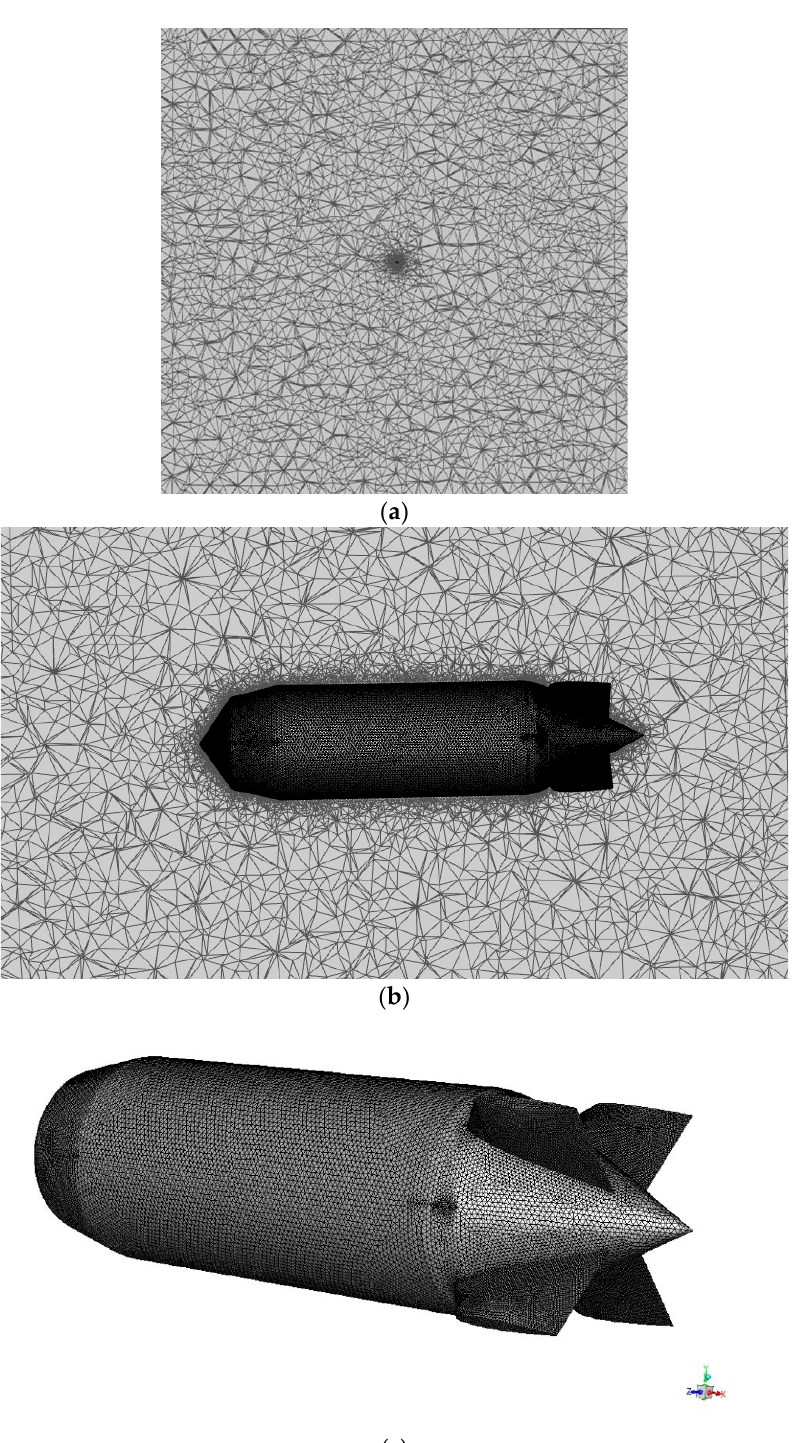
Figure 5. Fluid mesh condition of the airship. ( a ) Domain condition. ( b ) Mesh domain around the airship. ( c ) The surface mesh of the airship.